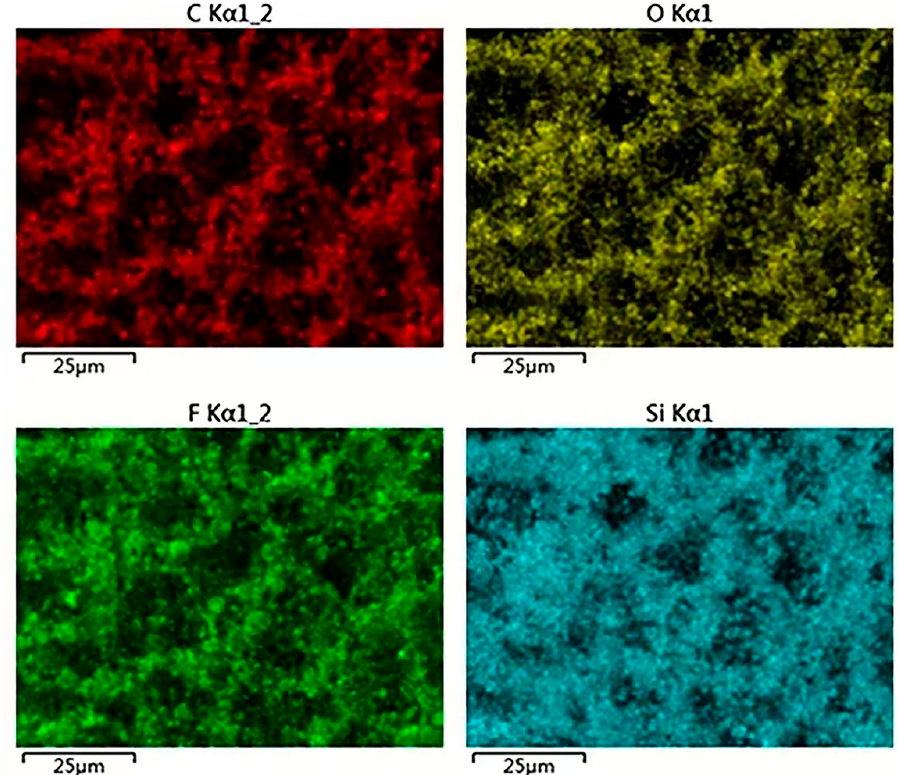
Figure 2. EDS analysis of DP8–1.5 layered membrane: C, O, F, Si element distribution.